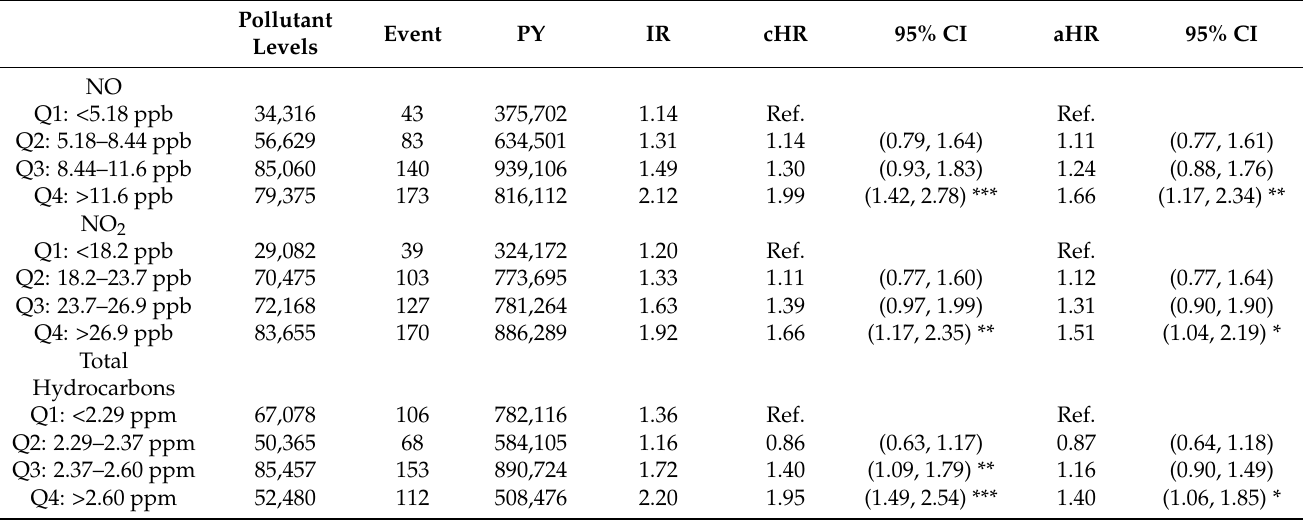
Table 4. Comparisons of pneumothorax incidence and associated hazard ratios by average annual concentration of air